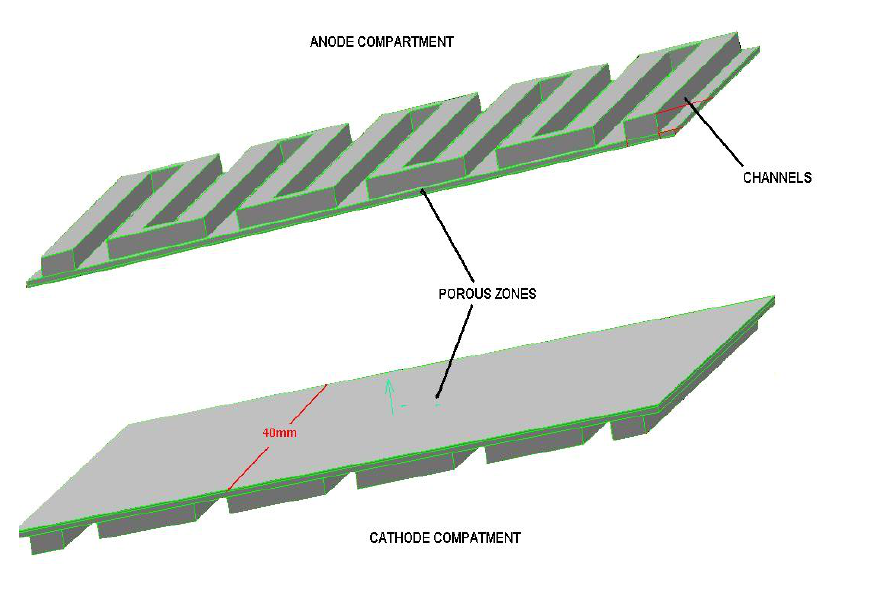
Figure 1. Simplified geometry model of the bipolar plate for anode and cathode